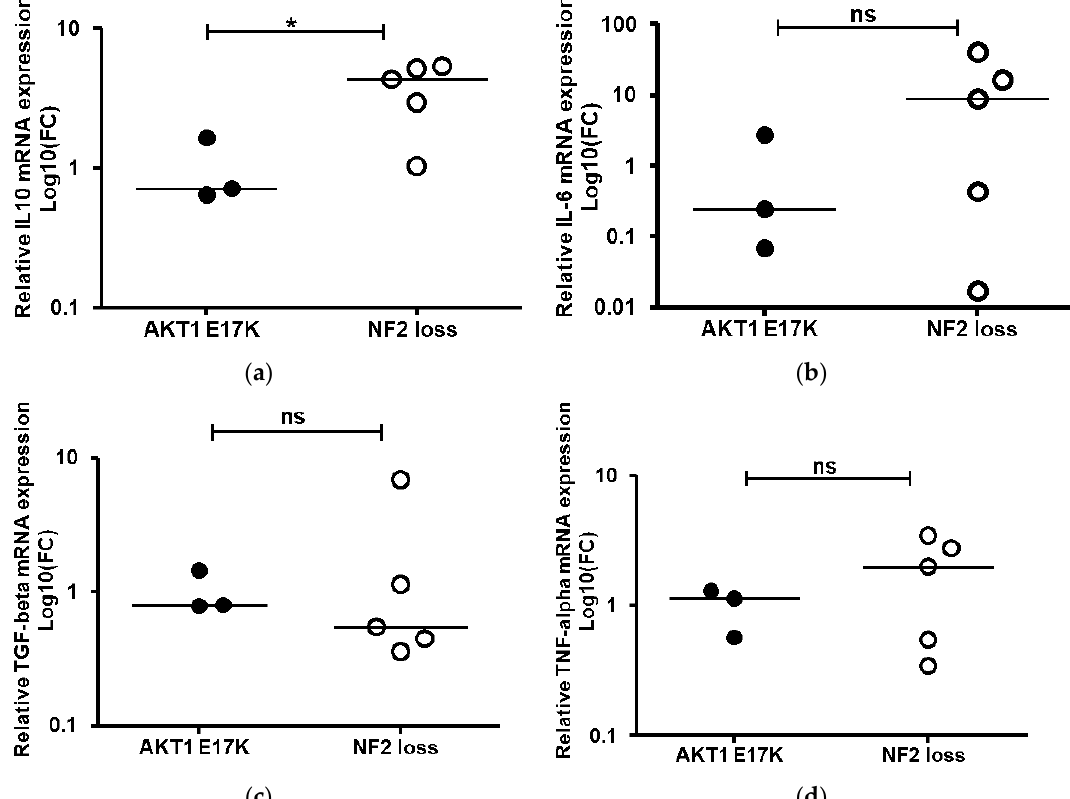
Figure 5. Quantitative real-time PCR (a) IL-10, (b) IL-6, (c) TGF-beta and (d) TNF-alpha mRNA expression levels. Relative quantification was obtained using the 2 −ΔΔCT method normalisation to healthy meninges tissue after using glyceraldehyde-3-phosphate dehydrogenase (GAPDH) as an internal control. Data shown as log 10-fold change (FC) for AKT1 E17K ( n = 3) and WHO grade I NF2-negative ( n = 5) meningiomas; line represents the median, * p < 0.05, ns: not significant.